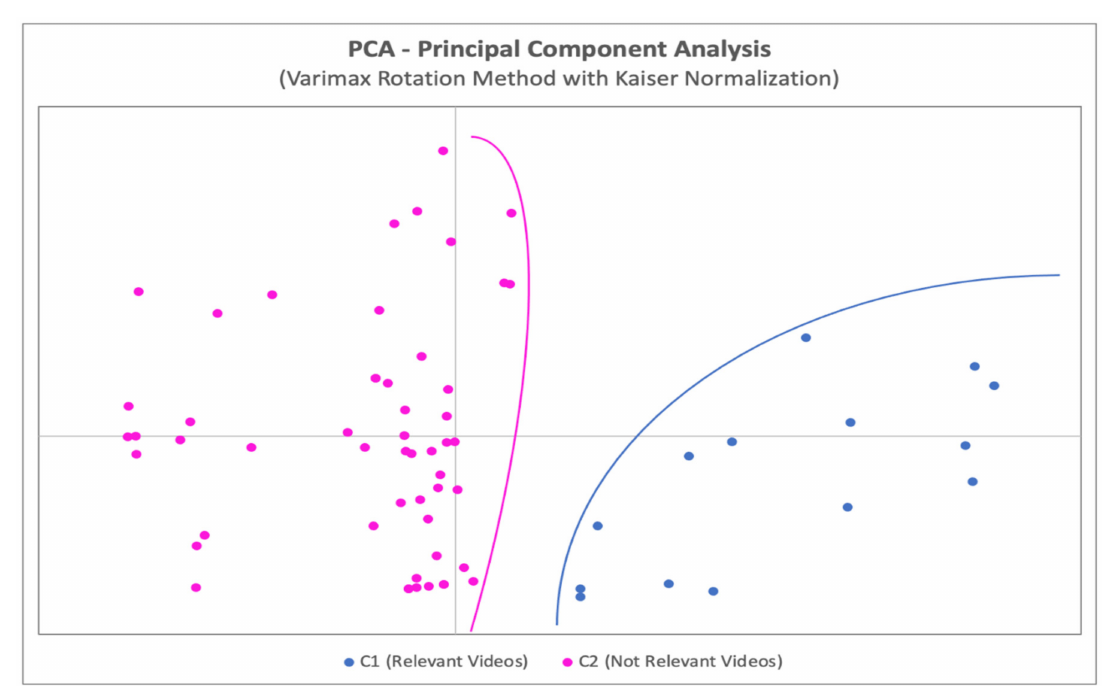
Figure 2. Principal component analysis graphical auto-classification of the